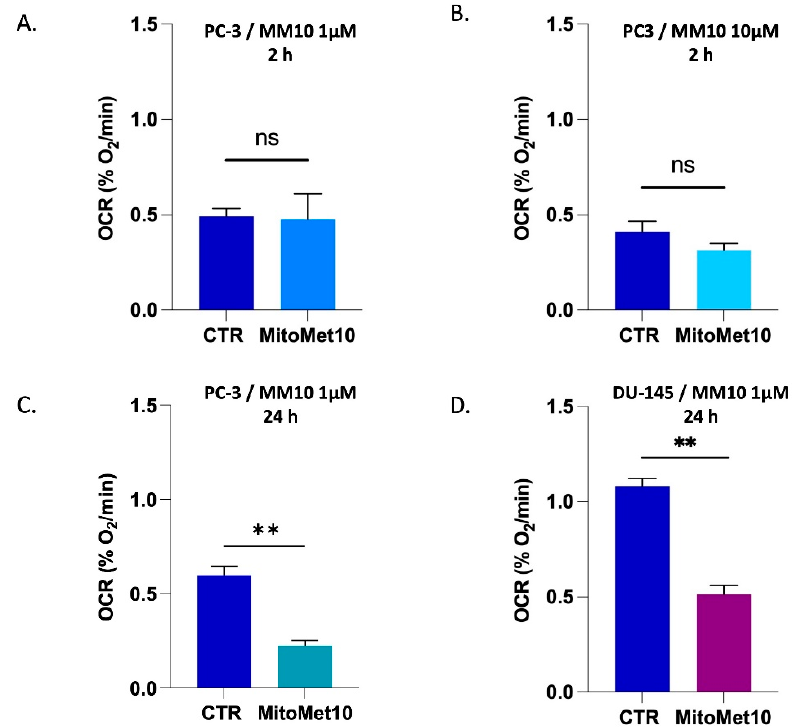
Figure 2. Impact of MM10 on the oxygen consumption rate (OCR) of prostate cancer cells measured by EPR respirometry. ( A ) Effect on OCR of PC-3 cells after 2 h exposure to MM10 (1 µM). ( B ) Effect on OCR of PC-3 cells after 2 h exposure to MM10 (10 µM). ( C ) Effect on OCR of PC-3 cells after 24 h exposure to MM10 (1 µM). ( D ) Effect on OCR of DU-145 cells after 24 h exposure to MM10 (1 µM). Bars represent means ± SEM (% O 2 /min), (**) p < 0.01, (ns) non-significant ,Student’s t test, N = 3.